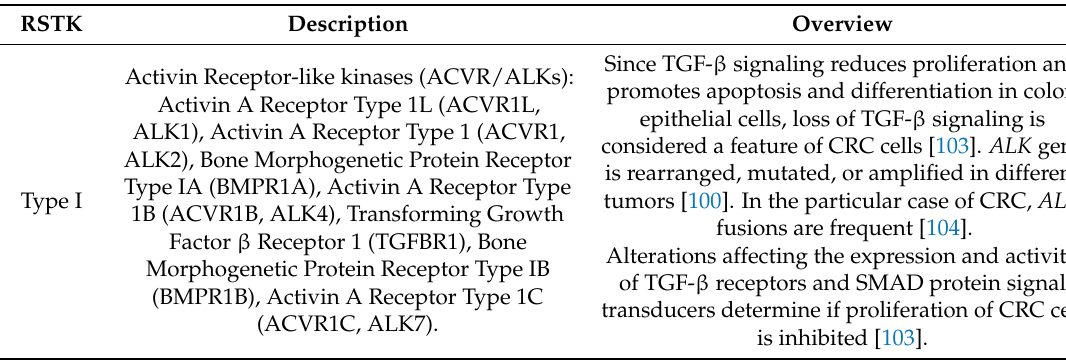
Table 3. Receptor Serine/Threonine Kinase Subfamilies